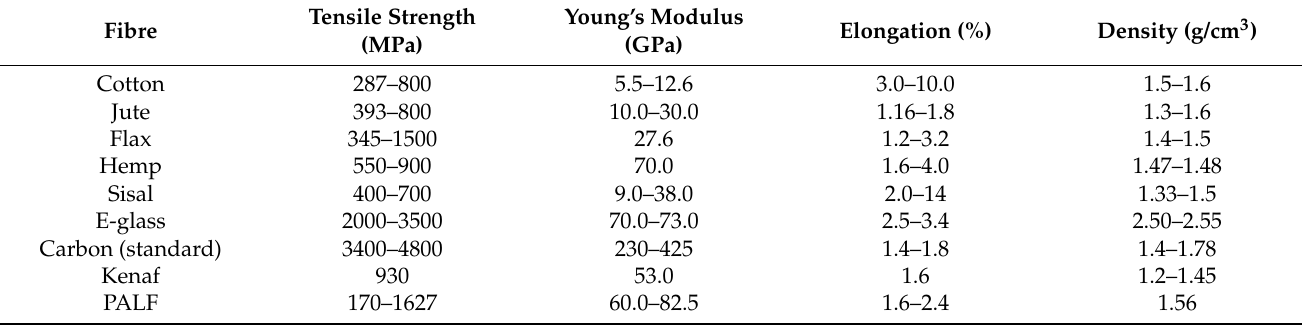
Table 1. Fibre characteristic values for tensile strength (MPa), Young’s Modulus (GPa), elongation (%) and density (g/cm 3 ) [11–15].